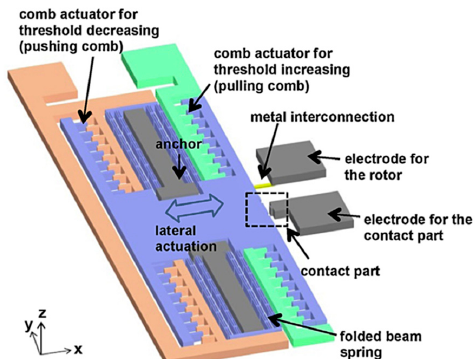
Figure 6. A switch with comb driving actuators as a mechanism of threshold tuning for threshold bi-directional tunability [25].